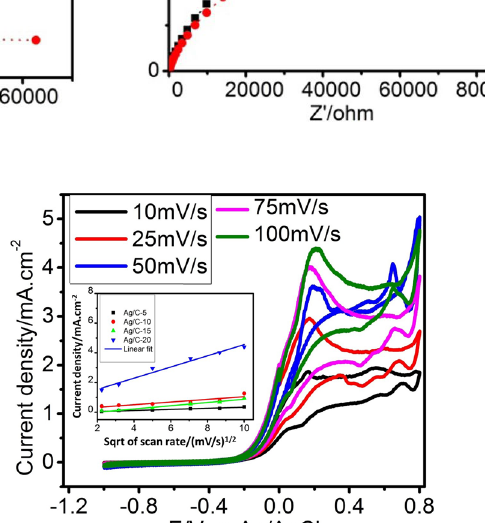
Fig. 4 a EIS at 0.5 M NaOH solution on Ag/C-5 and Ag/C- 20 modified electrodes, b EIS at 0.5 M NaOH + 1 M EtOH on Ag/C-5 and Ag/C-20 modified electrode